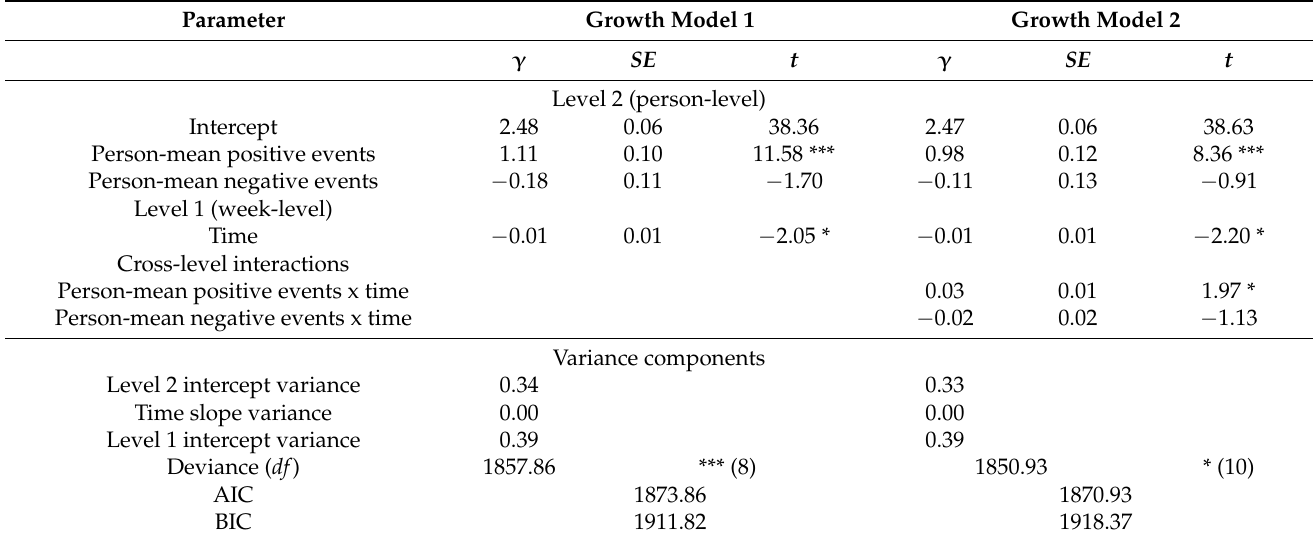
Table 4. Growth Curve Modeling Analysis Predicting Trajectories of Work Engagement Over